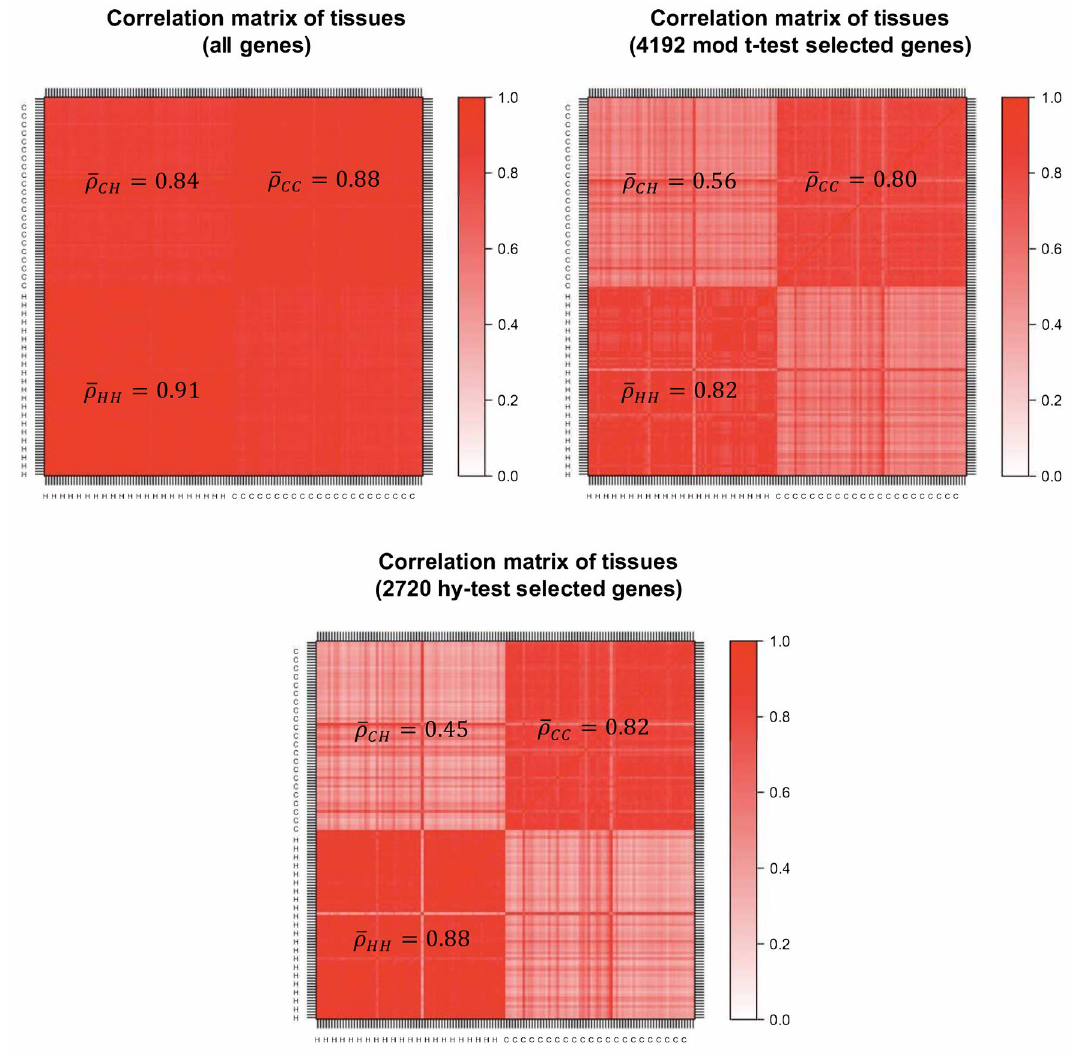
Figure 3. Correlation structure of kidney cancer expression genes. Top-left panel refers to all genes, the top- right panel refers to the set of genes selected by moderated t-test, and the bottom panel refers to the set of genes selected by the Hy-test. ¯ ̺ is the block average